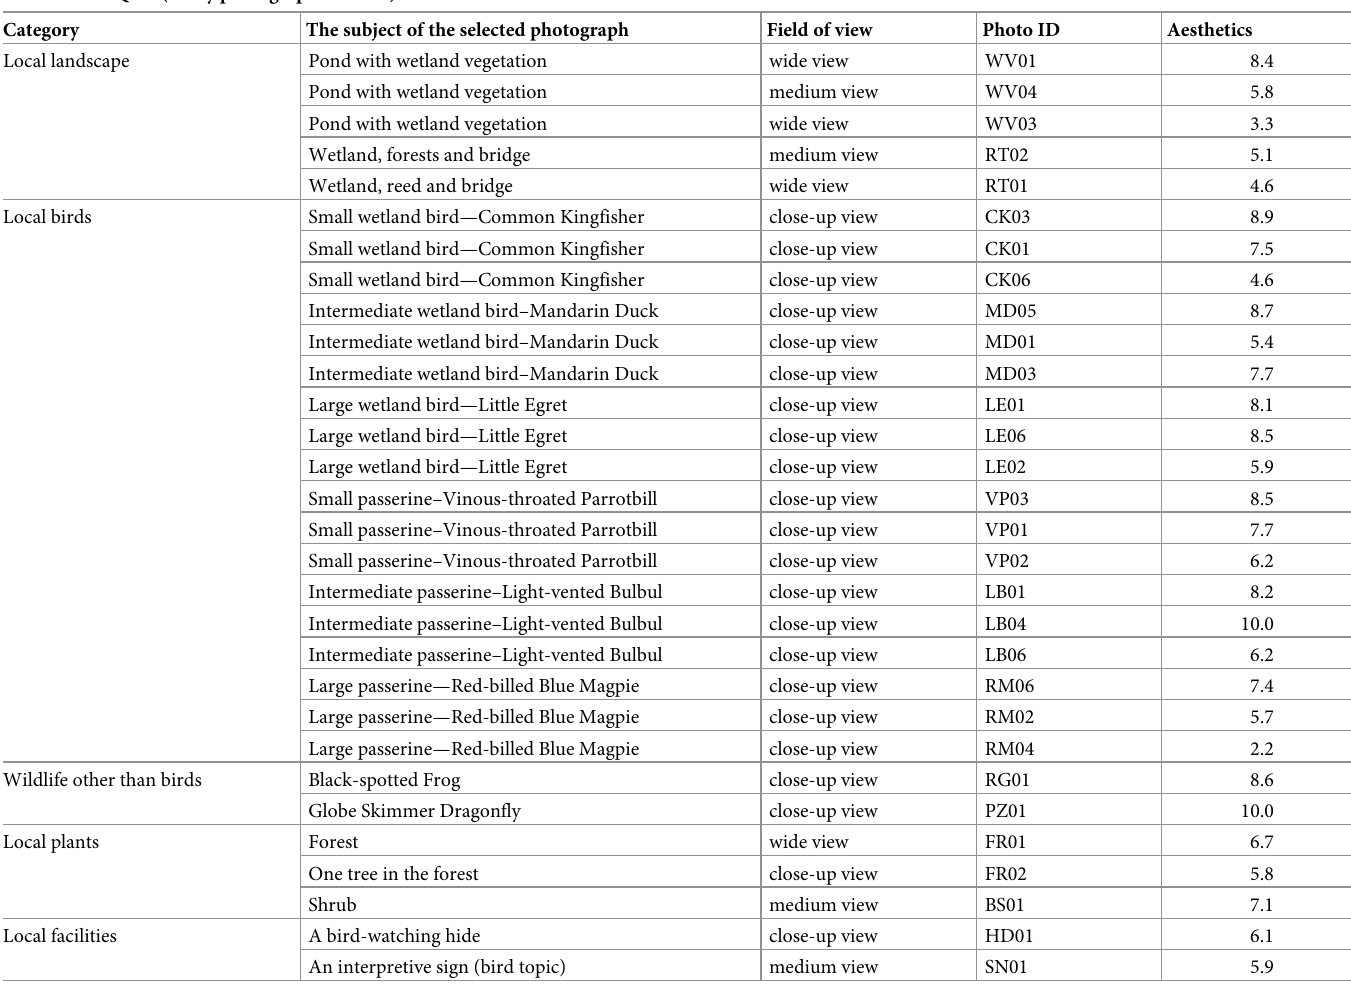
It includes what natural attractions were presented and how they were presented (field of view). The aesthetic scores were given by Acquine. The Common Kingfisher ( Alcedo atthis ), Mandarin Duck ( Aix galericulata ), Little Egret ( Egretta garzetta ), Vinous-throated Parrotbill ( Sinosuthora webbiana ), Light-vented Bulbul ( Pycnonotus sinensis ), Red-billed Blue Magpie ( Urocissa erythroryncha ), Black-spotted Frog ( Pelophylax nigromaculata ) and Globe Skimmer Dragonfly ( Pantala flavescens ) are locally common